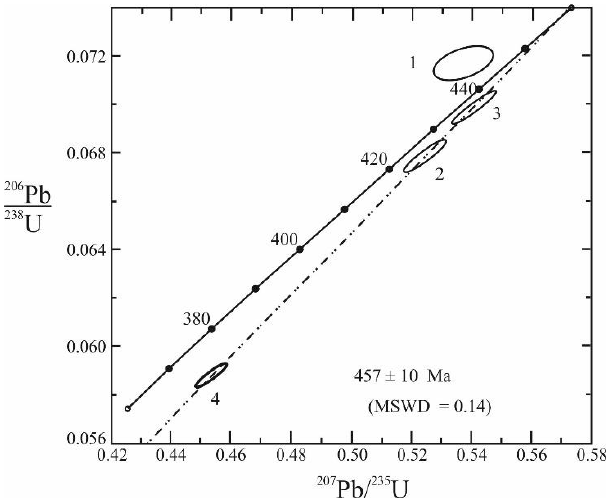
Figure 6. U-Pb dating results and concordia diagrams for melanocratic foyaites of the Saibar intru- sion.